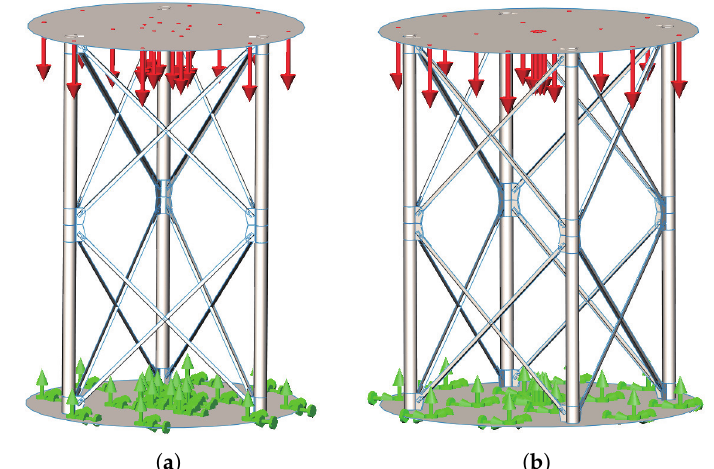
Figure 12. ( a ) The loading model of the triangular tower. ( b ) The loading model of the quadrilat- eral tower.